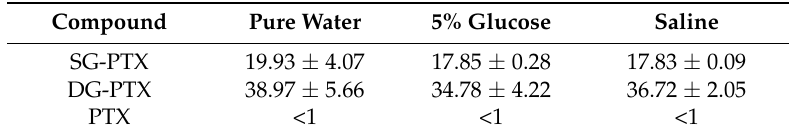
Table 1. Solubility ( µ g/mL) of SG-PTX, DG-PTX, and PTX. All values are expressed as mean ± SD. (n = 4). “SG-PTX” stands for single glucose-conjugated PTX prodrug, “DG-PTX” for double glucose-conjugated PTX prodrug and “PTX” for paclitaxel.